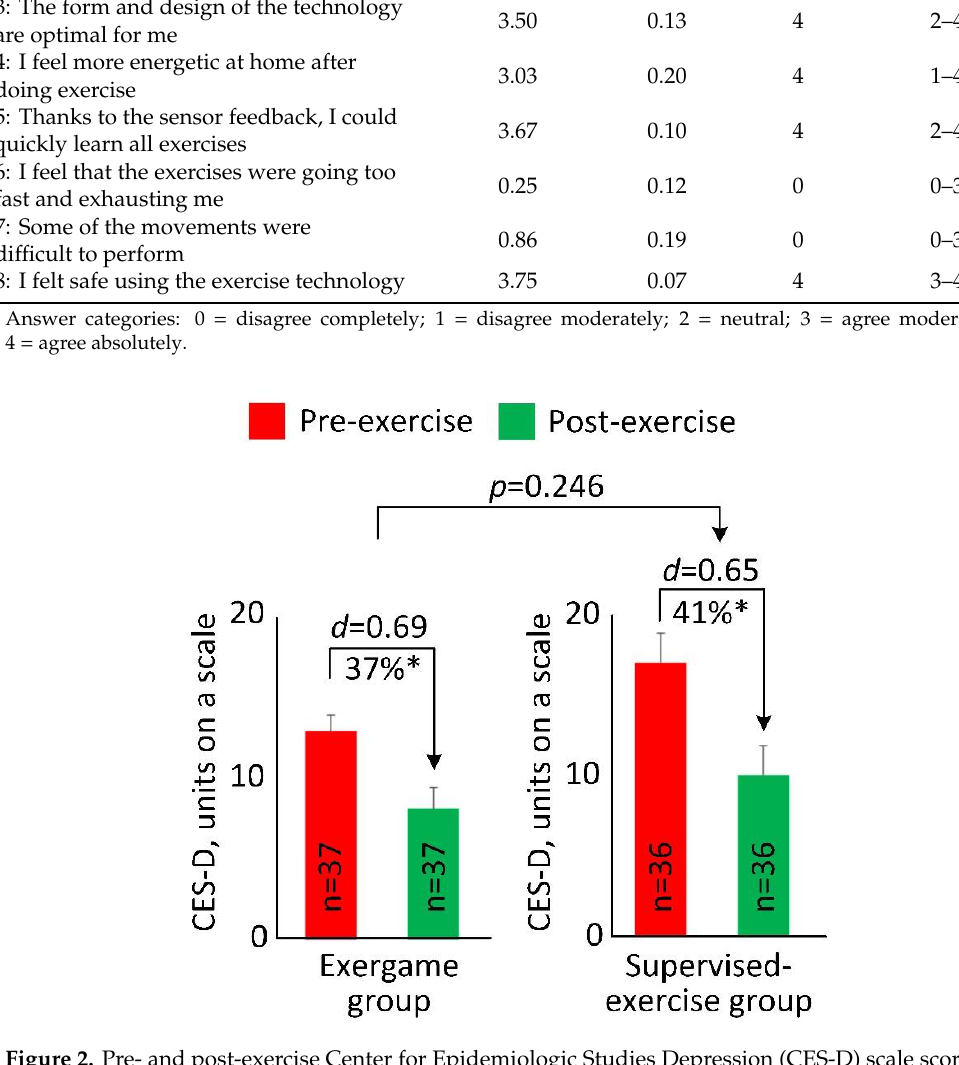
Figure 2. Pre- and post-exercise Center for Epidemiologic Studies Depression (CES-D) scale score for the exergame group and the supervised exercise group. The error bar represents the standard error. “ n ” denotes number of participants per group. “ d ” denotes Cohen’s d effect size calculated between pre- and post-exercise for each group. “*” denotes when the pre- and post-exercise comparison achieved a statistically significant level ( p < 0.050).